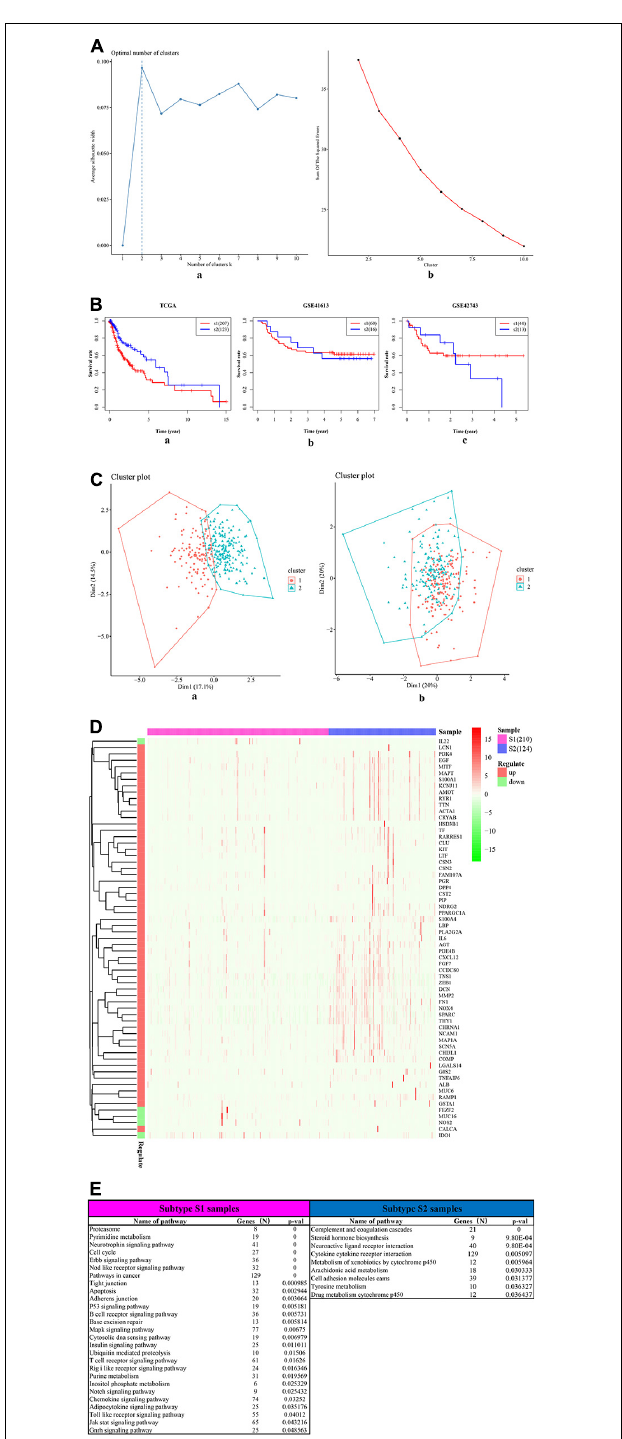
FIGURE 5 | The two survival subtypes of OSCC differentiated by deep learning-based model. (A) The clustering evaluation plots drawn by using the silhouette index (a) and Calinski–Harabasz criterion (b), respectively. (a) The silhouette index values for each number of clusters. The abscissa represents the number of clusters, and the ordinate represents the value of average silhouette width. The plot shows that the highest value of average silhouette